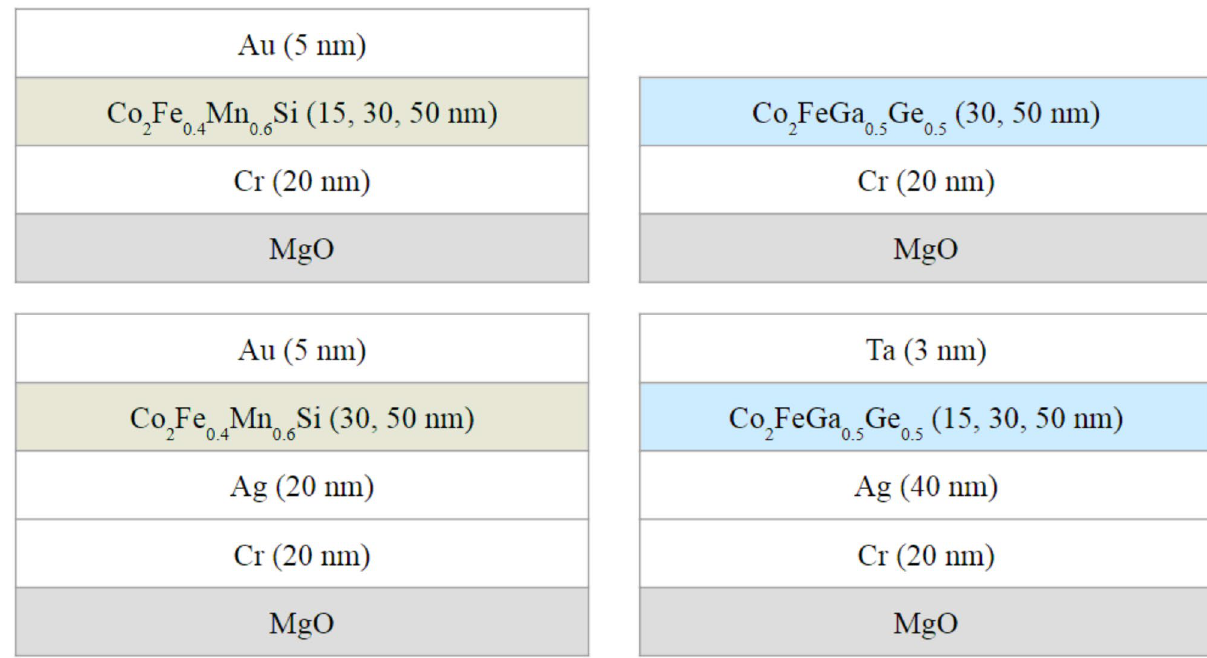
Figure 1. Investigated samples belong to 4 series: CFMS and CFGG on Cr buffer layer with or without the additional Ag buffer